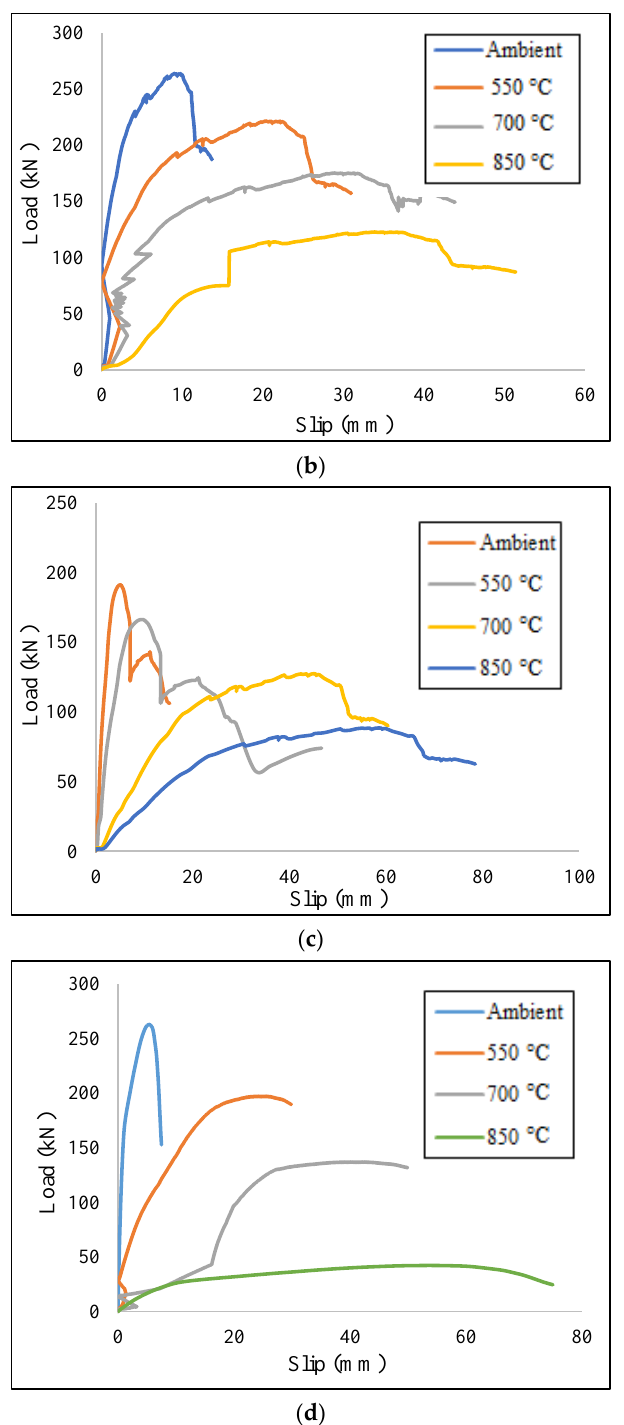
Figure 13. Load-slip curves of the FE models for ( a ) model with C7530, ( b ) model with C7550, ( c ) model with C10030 and ( d ) model with C10050 shear connector.